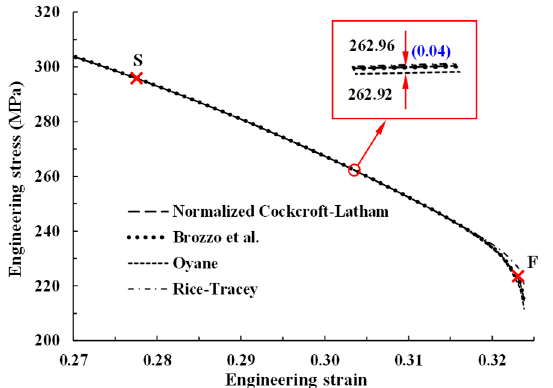
Figure 11. Tensile behavior predictions based on the softening and fracture points S and F, respec-